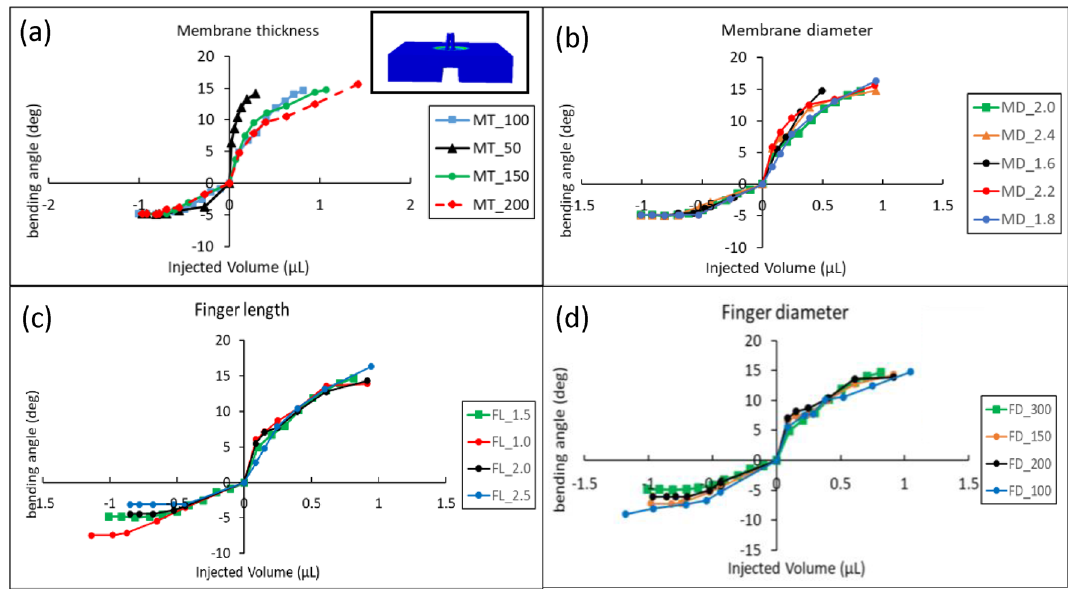
Figure 2. 3D model and simulation result for a square-shaped microgripper and bending of fingers versus injected volume. ( a ) The deflection of the fingers versus injected volume can be seen here for membrane thicknesses of 50 µm, 100 µm, 150 µm, and 200 µm. (Inset)Simulation of deformation of the fingers in the closing regime. ( b ) The deflection of the fingers for various injected volumes can be seen in this figure for membrane diameters of 1.6 mm, 1.8 mm, 2 mm, 2.2 mm, and 2.4 mm. ( c ) The deflection of the fingers for various injected volumes can be seen in this figure for the length of the fingers of 1 mm, 1.5 mm, 2 mm, and 2.5 mm. ( d ) The deflection of the fingers for various injected volumes can be seen in this figure for diameters of the fingers of 100 µm, 150 µm, 200 µm, and 300